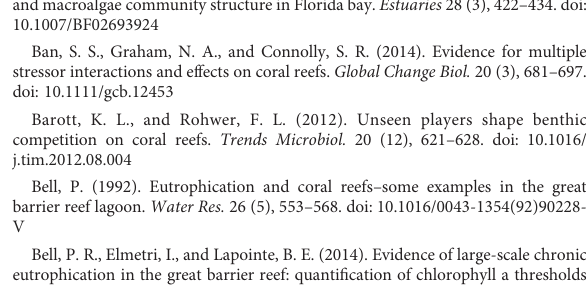
SUPPLEMENTARY FIGURE 2 Correlation plot of contributing variables and dimensions of the principal components to highlight the most contributing variables for each